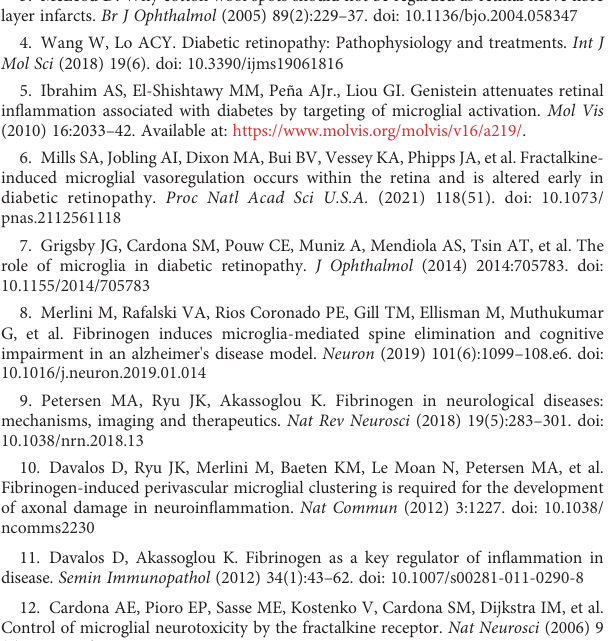
taken per mouse. Data show mean ± SD, n = 4 to 10 mice per group where each dot represents an individual mouse. * P <0.05, ** P <0.01, *** P <0.001 SUPPLEMENTARY FIGURE 5 PLX-5622 treatment does not alleviate vascular damage in the diabetic mCX3CR1 I250/WT and mCX3CR1 M281/WT retina. Microglia were pharmacologically depleted using PLX-5622 in non-diabetic and 8-wks diabetic CX3CR1 -WT, mCX3CR1 I250/WT and mCX3CR1 M281/WT mice for two weeks. Non-diabetic control mice received citrate buffer. Non-depleted, non-diabetic and diabetic controls remained on normal chow. Confocal images of retinal tissues stained for CD31 (red) (A) and fi brinogen (white) (B) in CX3CR1 -WT, mCX3CR1 I250/WT and mCX3CR1 M281/WT mice. Confocal images represent the retinal ganglion cell layer in the peripheral retina. (C, D) , Quanti fi cation of retinal IHC analysis for CD31 + percent immunoreactive area (C) and fi brinogen + percent immunoreactive area (D) . Data show the average of the 2 central, 2 medial and 2 peripheral images taken per mouse. Data show mean ± SD, n = 4 to 10 mice per group where each dot represents an individual mouse. * P <0.05, ** P <0.01, *** P <0.001 **** P <0.0001 using 2- way ANOVA. Scale bars measure 50µm. SUPPLEMENTARY FIGURE 6 PLX-5622 treatment does not prevent TUJ1 + axonal loss or vascular damage inthediabetic mCX3CR1 I250/WT and mCX3CR1 M281/WT retina. (A) Experimental design to pharmacologically deplete microglia in non-diabetic and 8-wks diabetic CX3CR1 -WT, mCX3CR1 I250/WT and mCX3CR1 M281/WT mice for two weeks. Non-diabetic control mice received citrate buffer. Non-depleted, non-diabetic and diabetic controls remained on normal chow. (B, C) , Merged confocal images of retinal tissues stained for TUJ1 (turquoise) and GFAP (magenta) (B) and CD31 (red) and fi brinogen (green) (C) in CX3CR1 -WT, mCX3CR1 I250/WT and mCX3CR1 M281/WT mice. Confocal images represent the peripheral retina. Scale bars measure